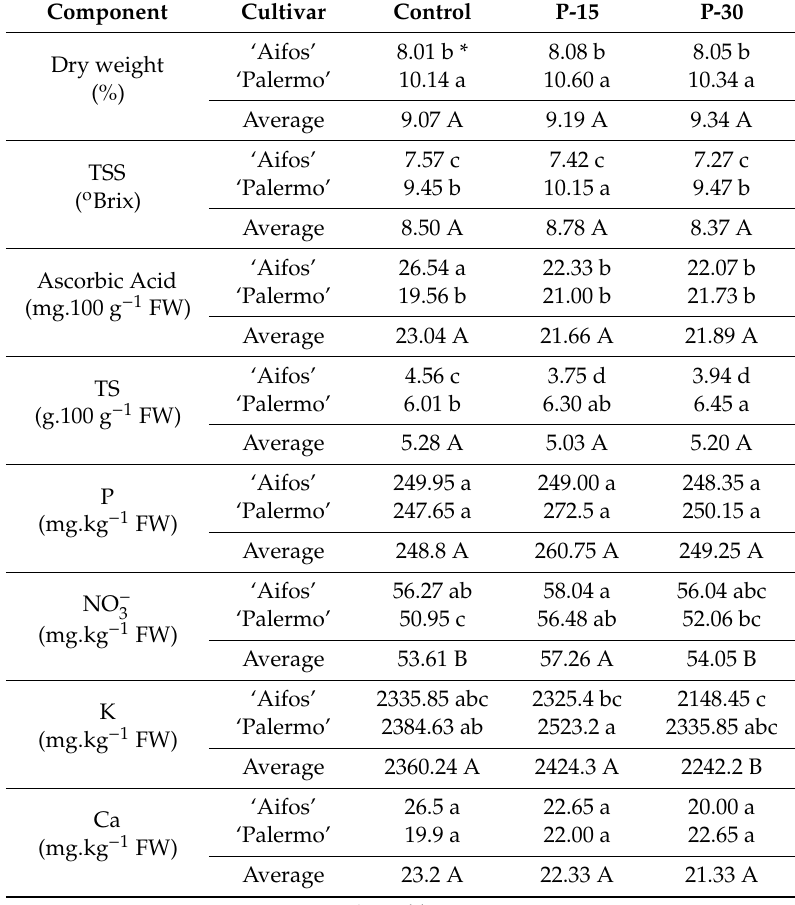
Table 3. E ff ects of fertilizer with polyphosphates in hydroponic cultivation on the concentration of dry weight and chosen chemical components in pepper fruit depending on the cultivar (average of two terms).